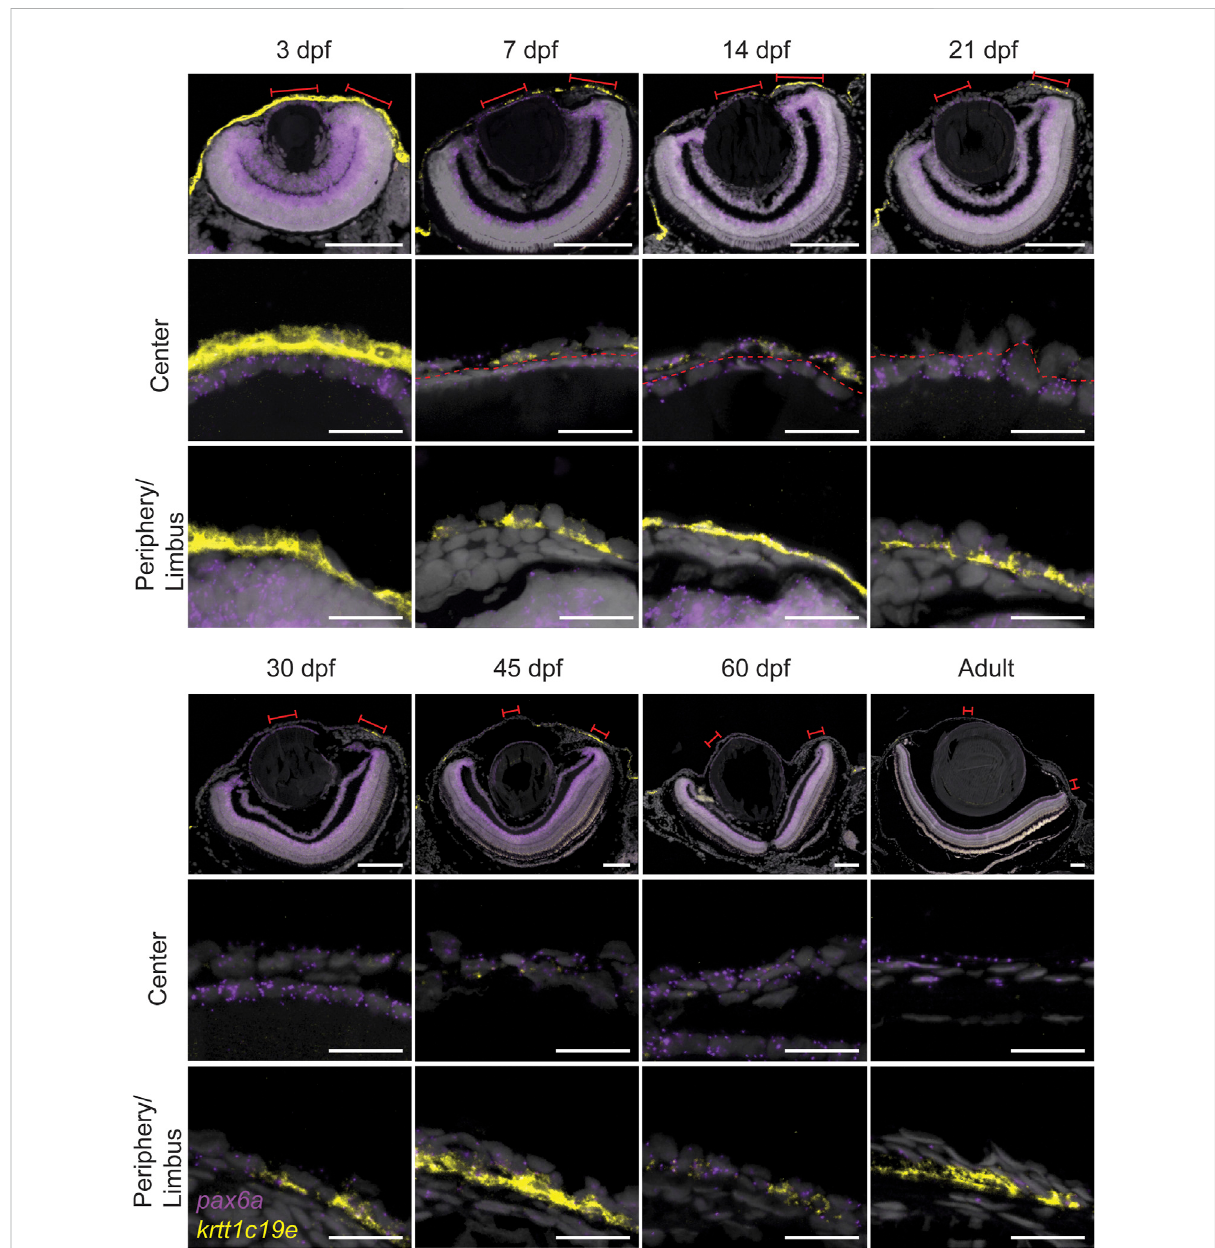
FIGURE 9 Expression of pax6a (red)and krtt1c19e (yellow)during corneal maturation.RNAScope insitu hybridization on5-µmsections,redlinesindicate areas in magni fi ed images in center and periphery. Dashed line indicates the border between lens epithelium and cornea. 3 samples were checked per age group. Scale bars: 100 µm in the overview images, 20 µm in the magni fi ed